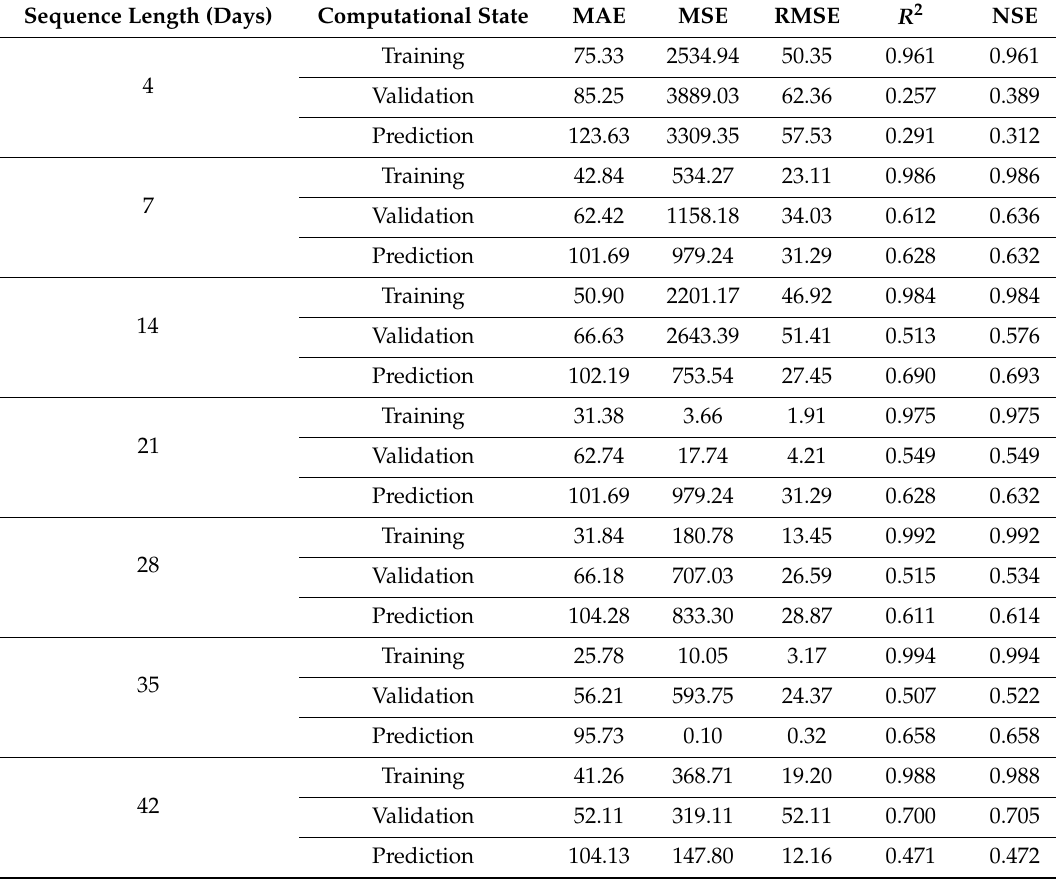
Table 6. Performance comparison of GRU with variation of sequence length. Sequence Length (Days)